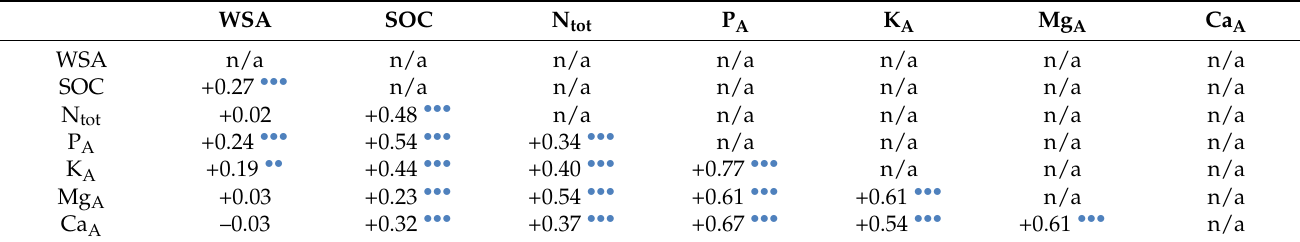
Table 8. Pearson’s correlations between aggregate stability soil chemical